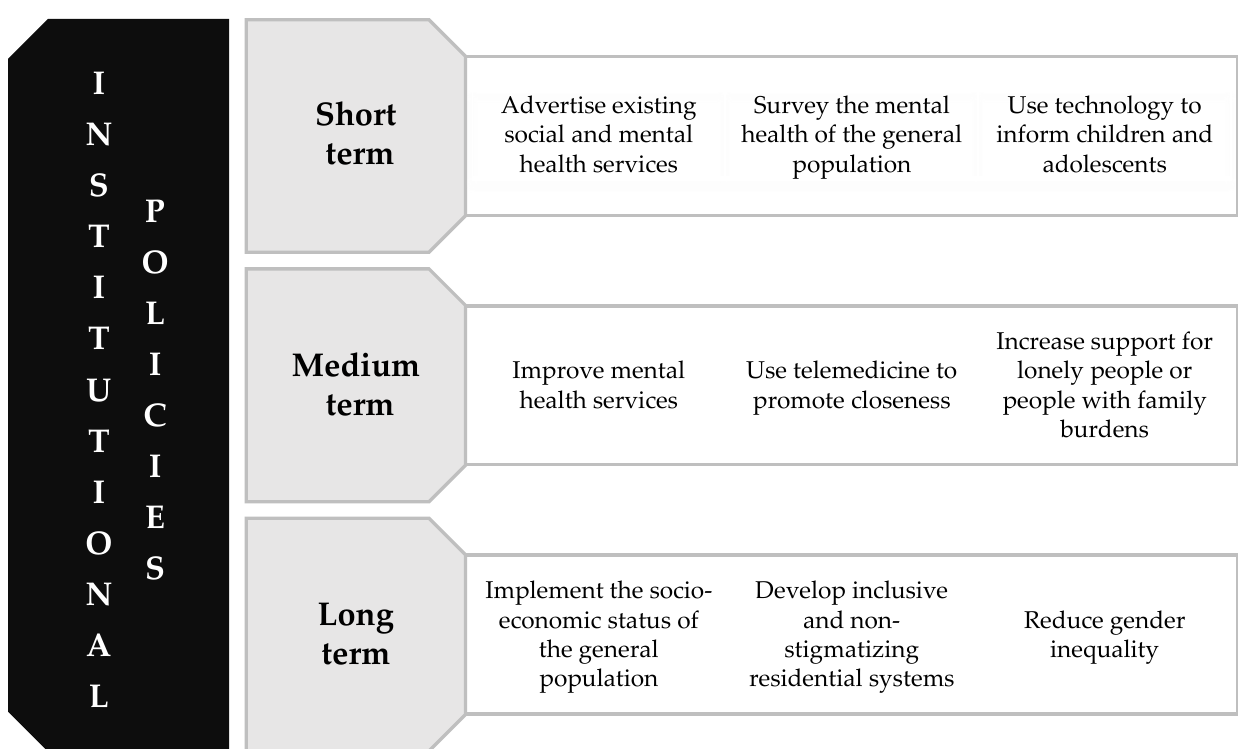
Figure 2. Suggestions for socio-health policies to support the general